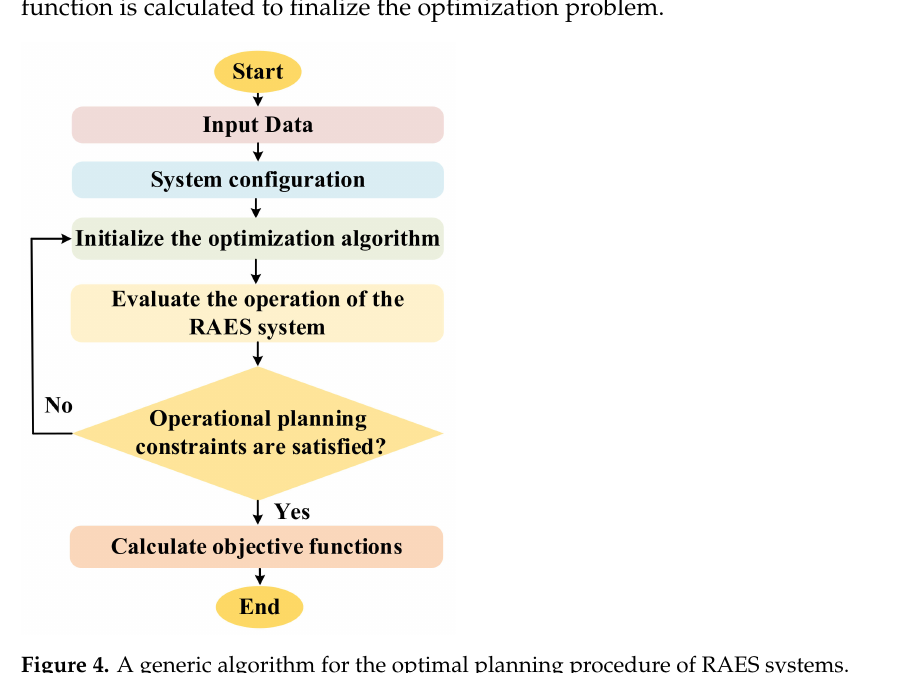
Figure 4. A generic algorithm for the optimal planning procedure of RAES